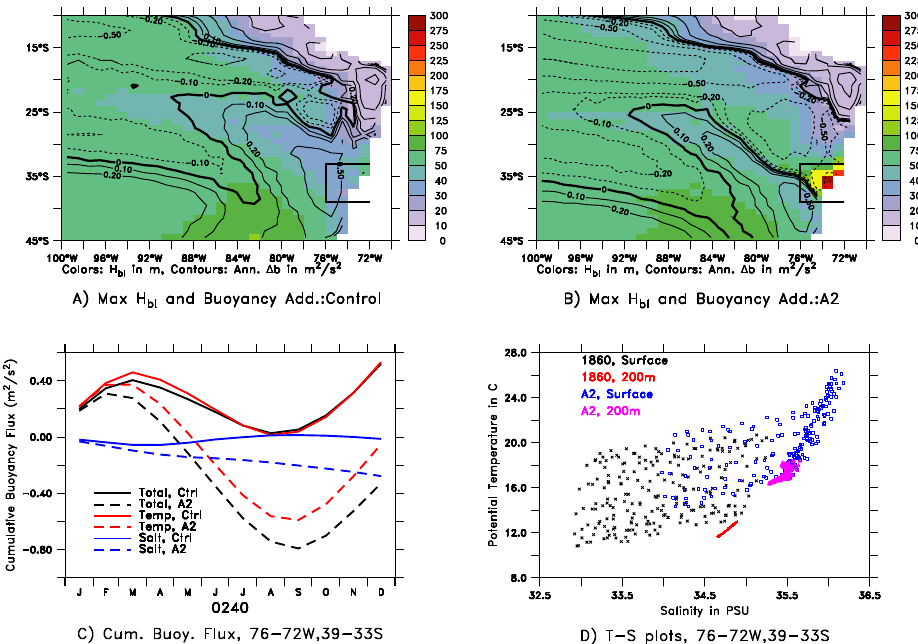
Fig. 5. Physical mechanisms behind increased O 2 supply to the Southeast Pacific. (A) Maximum monthly-averaged boundary layer depth in m (depth of active mixing from KPP code) and annually integrated buoyancy flux 1B in m 2 s − 2 (Eq. 3) in 1860 Control. Contours are at 0, ± 0.1, ± 0.2, ± 0.5, ± 1 and ± 2. (B) Maximum monthly-averaged boundary layer depth and 1B in A2 run years 2281–2300, contours as in (A) . (C) Cumulative buoyancy flux from 76 ◦ W–72 ◦ W, 39 ◦ S–33 ◦ S. Total is shown in black, contribution from temperature in red, and contribution from salinity in blue. Control runs are solid lines, while A2 is dashed. (D) Monthly T-S plots for all ocean grid points between 76 ◦ W–72 ◦ W, 39 ◦ S–33 ◦ S. Black symbols show surface points and red symbols 200m points for Control. Blue symbols show surface points and purple points show 200m for A2